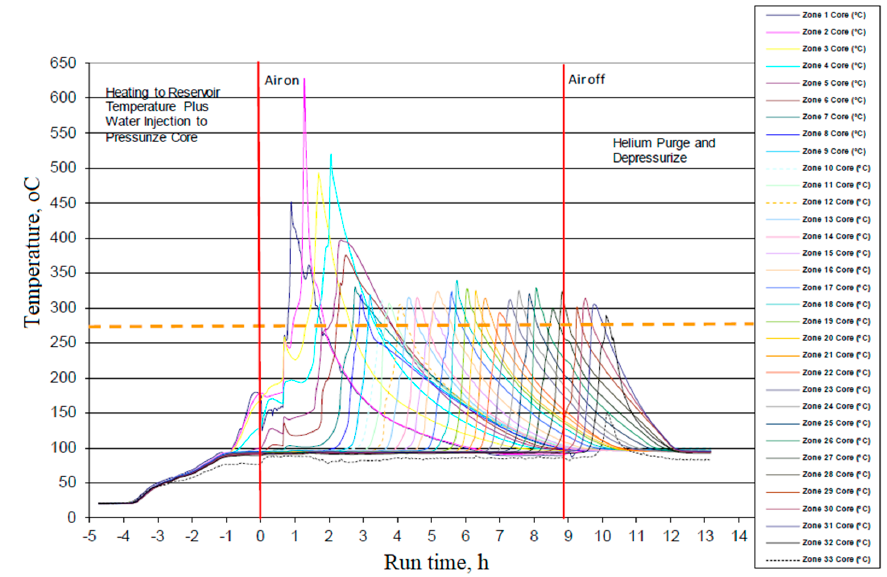
Figure 3. Forward Combustion Test Temperature Profiles (Color should be used).